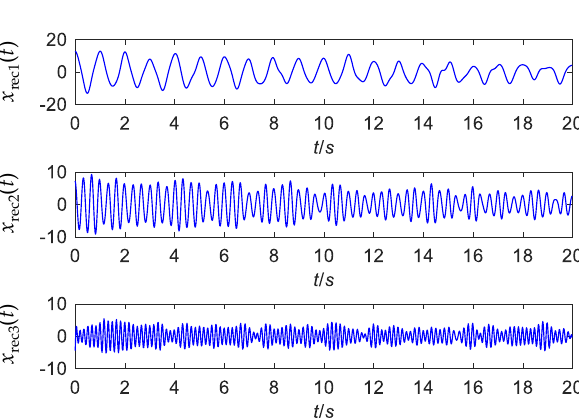
Figure 3. The mono-components of the simulated signal extracted by EWT.